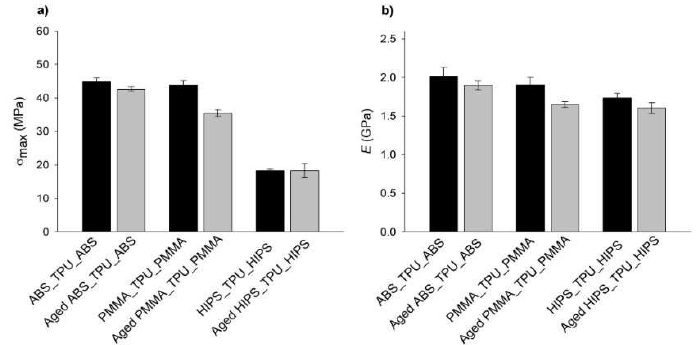
Figure 7. Determined ( a ) σ max and ( b ) E values of the dry and aged sandwich structure specimens that were obtained from the 3PB tests.